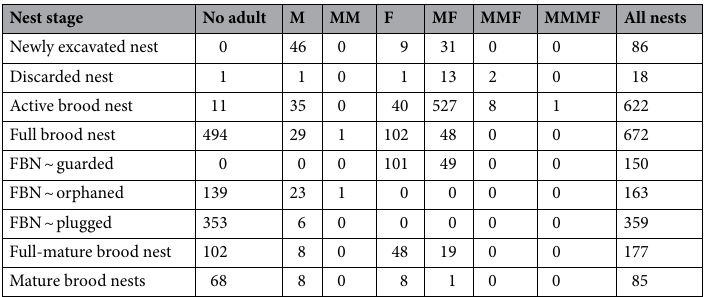
Table 2. Presence of individuals of parental generation in different nest stages. FBN full brood nest, M male, F